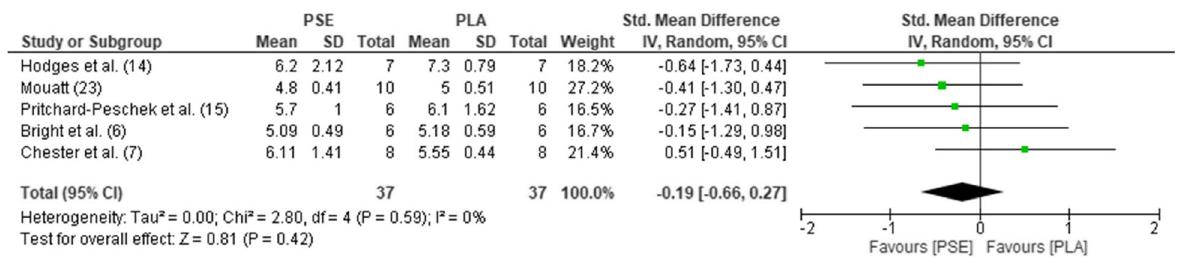
Fig. 5 Forest plot for effects of PSE on GLU with 95% confidence intervals. GLU, blood glucose; PSE, pseudoephedrine; PLA, placebo; SD, standard deviation; Std., standardised; IV, instrumental variables; CI, confidence interval. Positive effect sizes represent an increase in GLU due to PSE